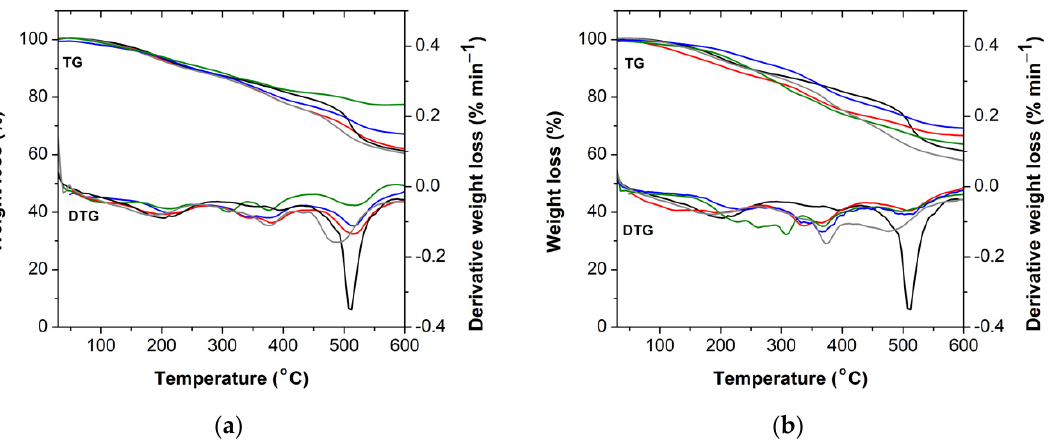
Figure 7. TG and DTG curves of resin without lignin (black), ( a ) with 30 wt% lignin; ( b ) with 50 wt% lignin. The used lignins were: dealkaline lignin (red), alkaline lignin (blue), lignosulfonate (green), and lignin-LA (gray). Note that all resins are optimized formulations (i.e., free formaldehyde content < 1 wt%).